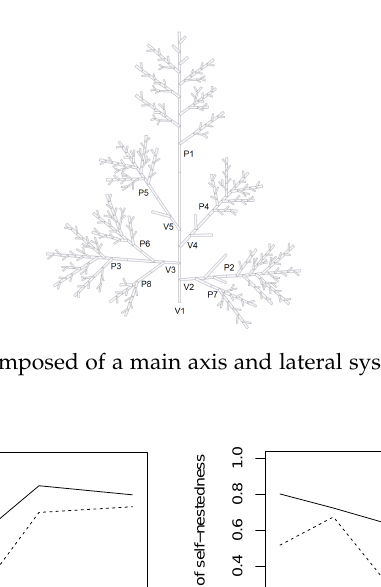
0 (dashed lines) and δ NeST (full lines) of the ∨